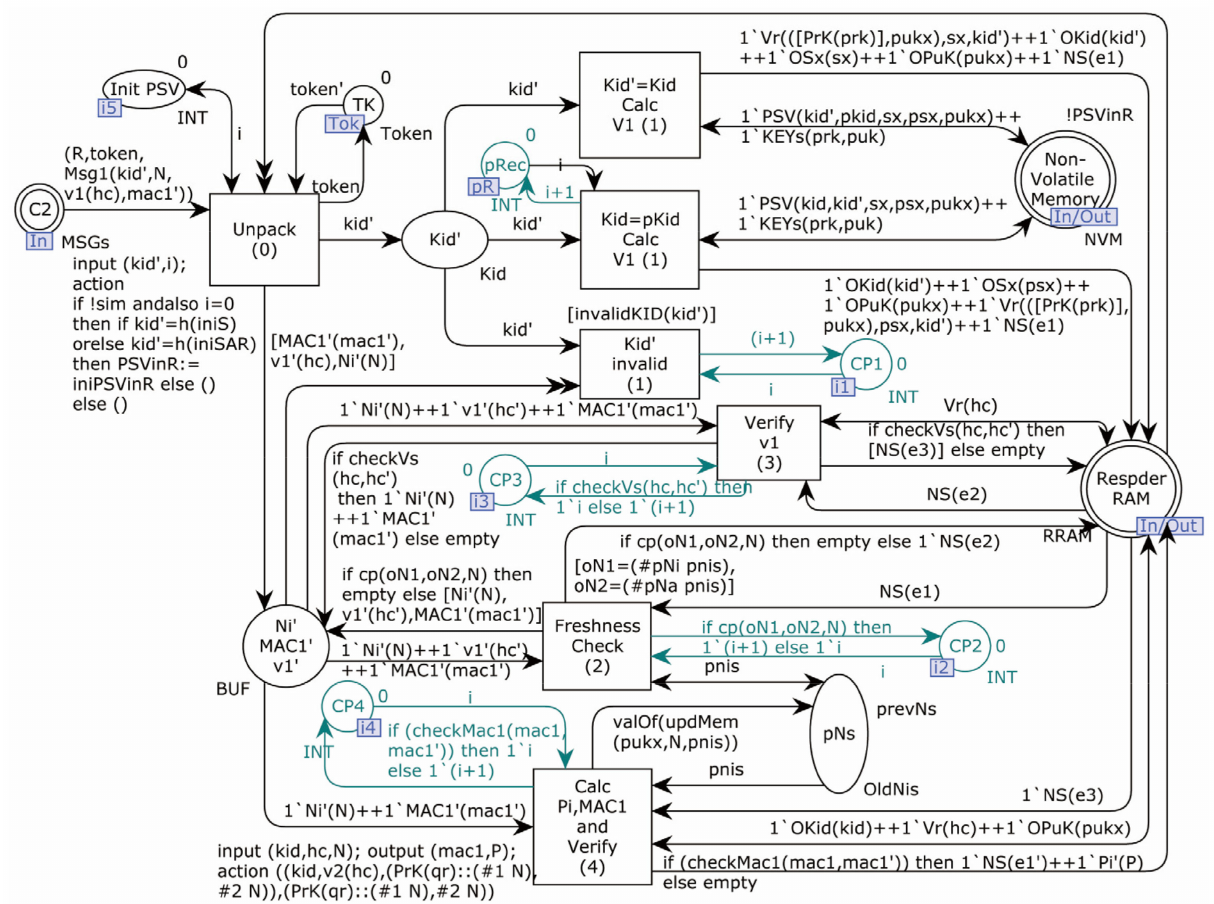
Figure 9. Responder model sub-page